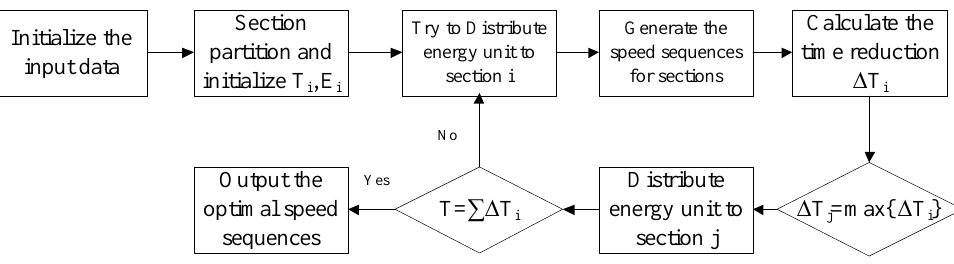
Figure 2. The flow chart for calculating the energy-efficient driving strategy of multiple sections.